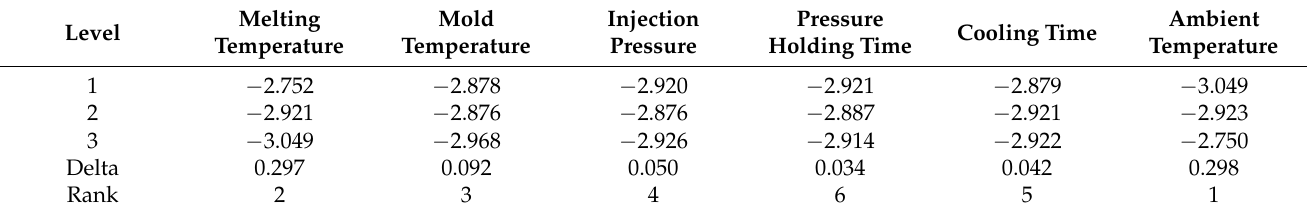
Table 4. Response table for S/N